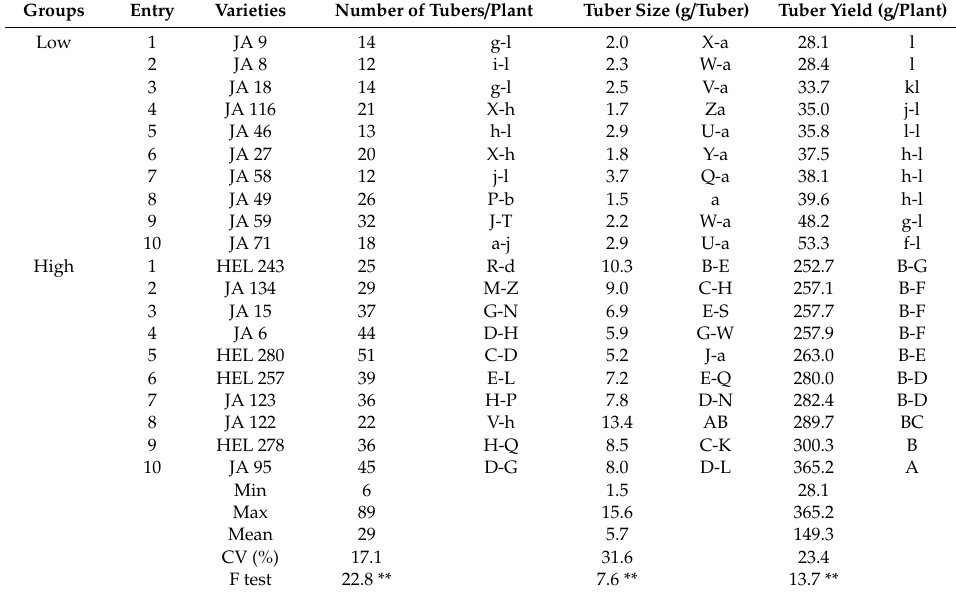
Table 5. Selected varieties of yield and yield component Jerusalem artichoke evaluated in early rainy season.